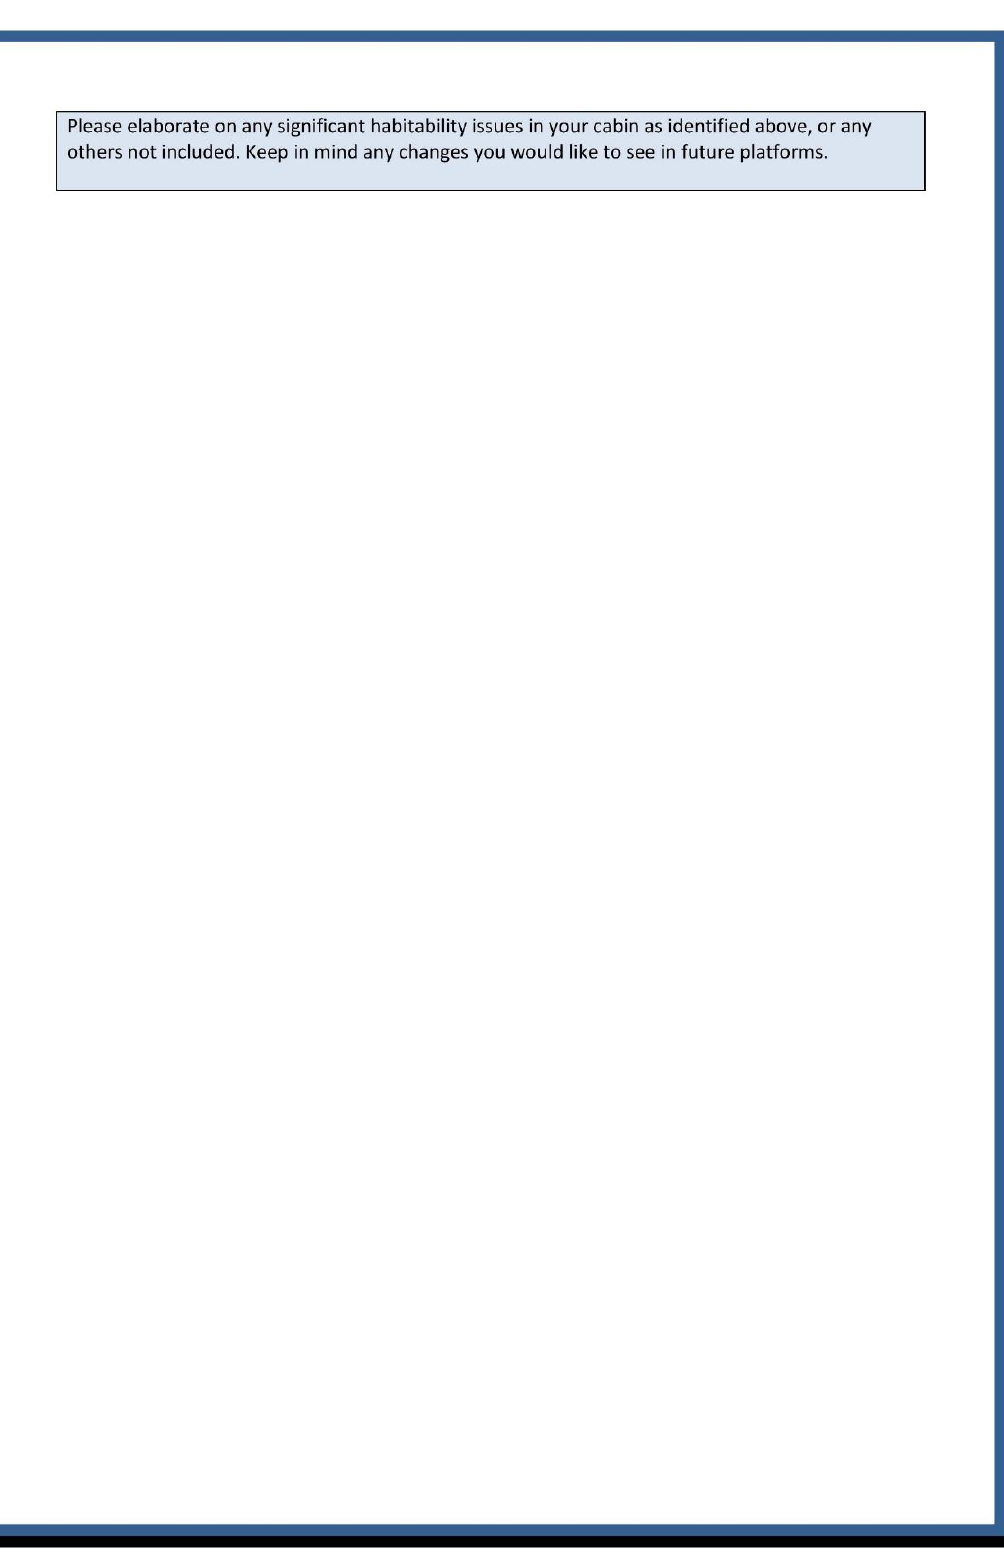
Figure A9. The Submarine Habitability Assessment Questionnaire (continued).